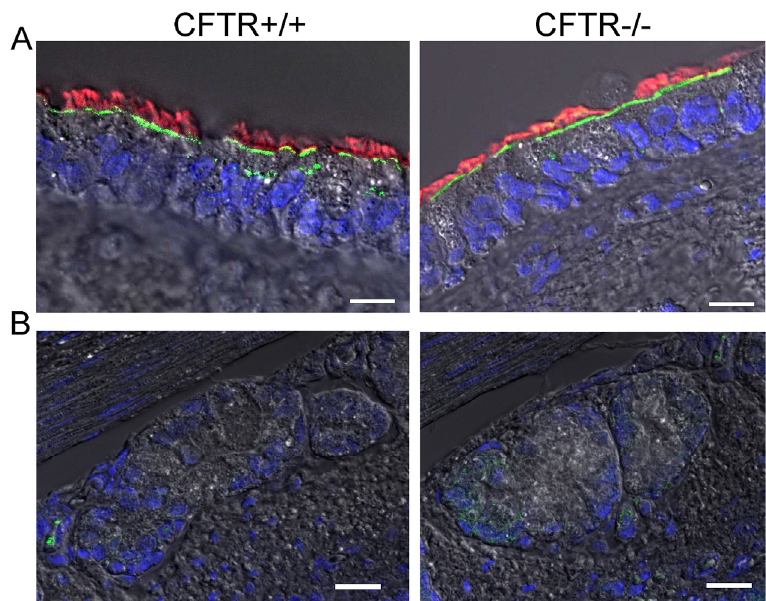
Figure 4. SLC26A9 is located in the apical membrane of ciliated airway epithelial cells of CFTR+/+ and CFTR-/- piglet lungs. ( A ) Immunocytochemistry of SLC26A9 (green) and acetylated tubulin (red) in superficial airway epithelium of wt (CFTR+/+) and CFTR-knockout (CFTR − / − ) piglets. ( B ) Expression of SLC26A9 was not detected in airway submucosal glands of CFTR+/+ and CFTR − / − piglets. Bar = 20 µm. Nuclei were stained by DAPI.